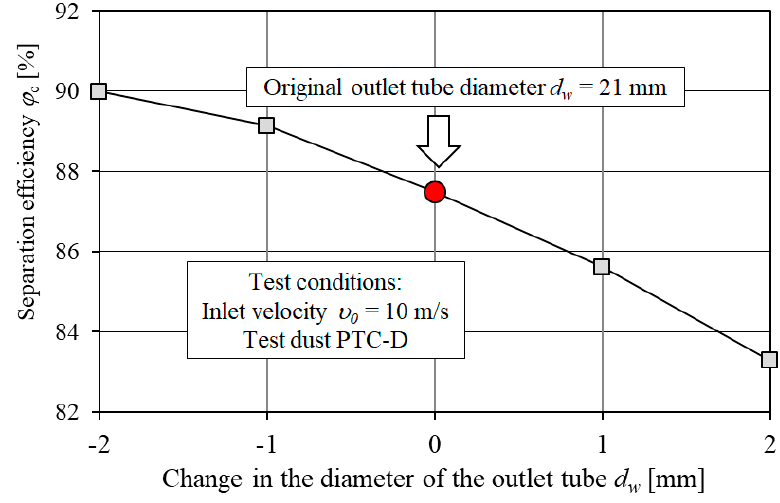
Figure 12. Cyclone separation efficiency φ c depending on the change of the internal diameter of the cyclone outlet pipe d w .